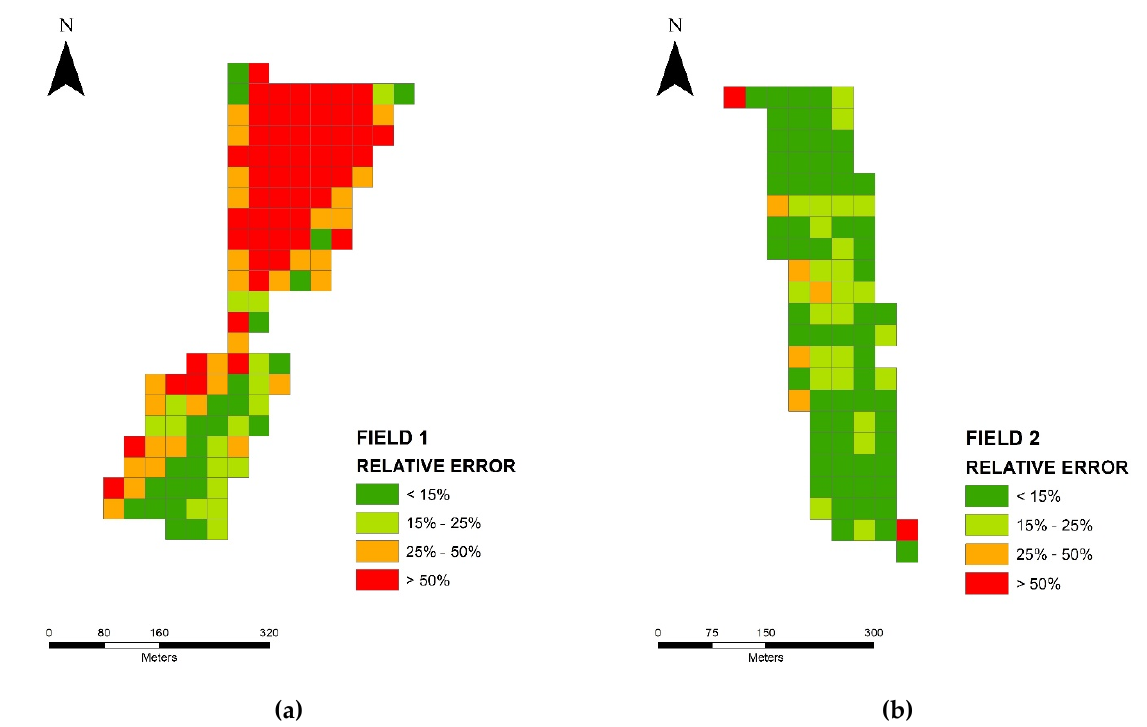
Figure 6. Relative error maps generated for Field 1 ( a ) and Field 2 ( b ) between measured and SEBAL-estimated yields.